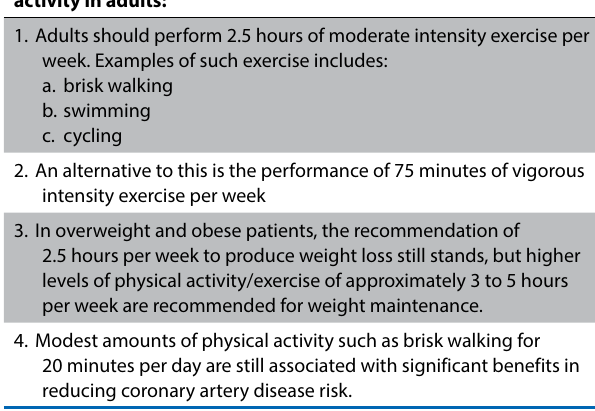
Table 6: Evidence-based recommendations regarding the use of exercise to reduce coronary artery disease (CAD) risk 13,29-31 The following are common recommendations for physical activity in adults: